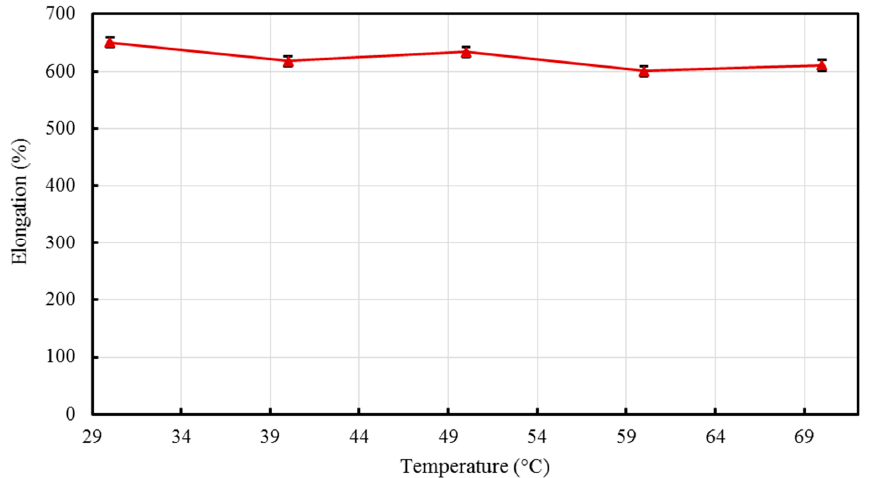
Figure 14. Effect of residence time on percentage of elongation of the developed HDPE-TiO 2 nanocomposites (SE bars included).